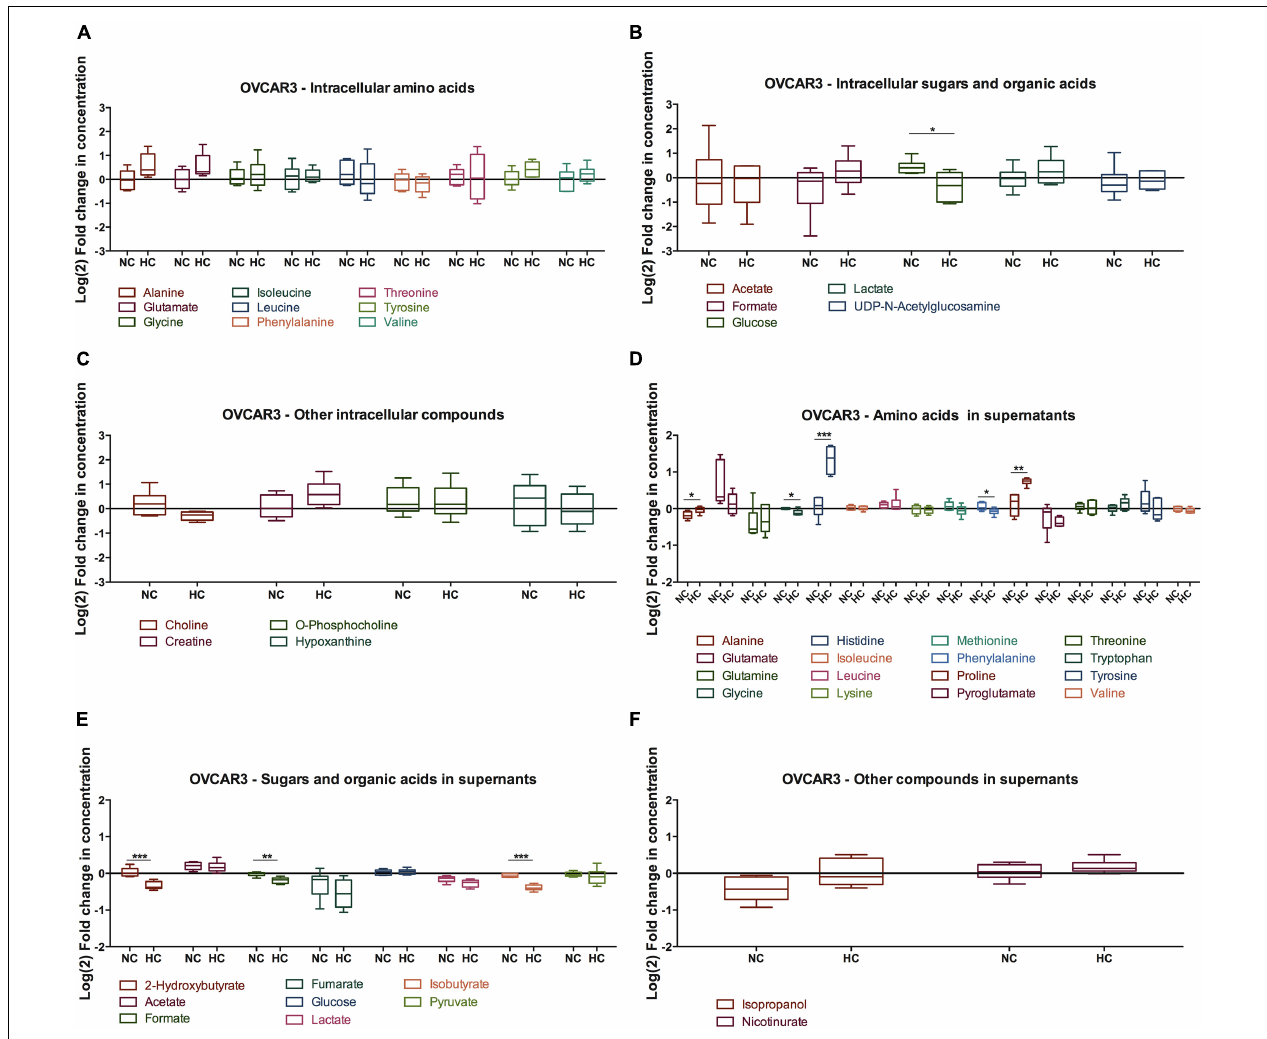
FIGURE 5 | Effect of cysteine in OVCAR3 metabolites under normoxia and hypoxia. Metabolites levels for 48 h of experimental conditions for OVCAR3 cells. (A) Intracellular amino acids; (B) intracellular sugars and organic acids; (C) other intracellular metabolites; (D) amino acids in supernatants; (E) sugars and organic acids in supernatants; (F) other metabolites in supernatants. Data were normalized to the respective control condition (the same environmental condition NC/N and HC/H). NC, normoxia with cysteine; HC, hypoxia with cysteine. Results are shown as median with 25th to 75th percentiles. * p < 0.05, ** p < 0.01, *** p < 0.001 (independent-samples t -test: NC, n = 6; HC, n =